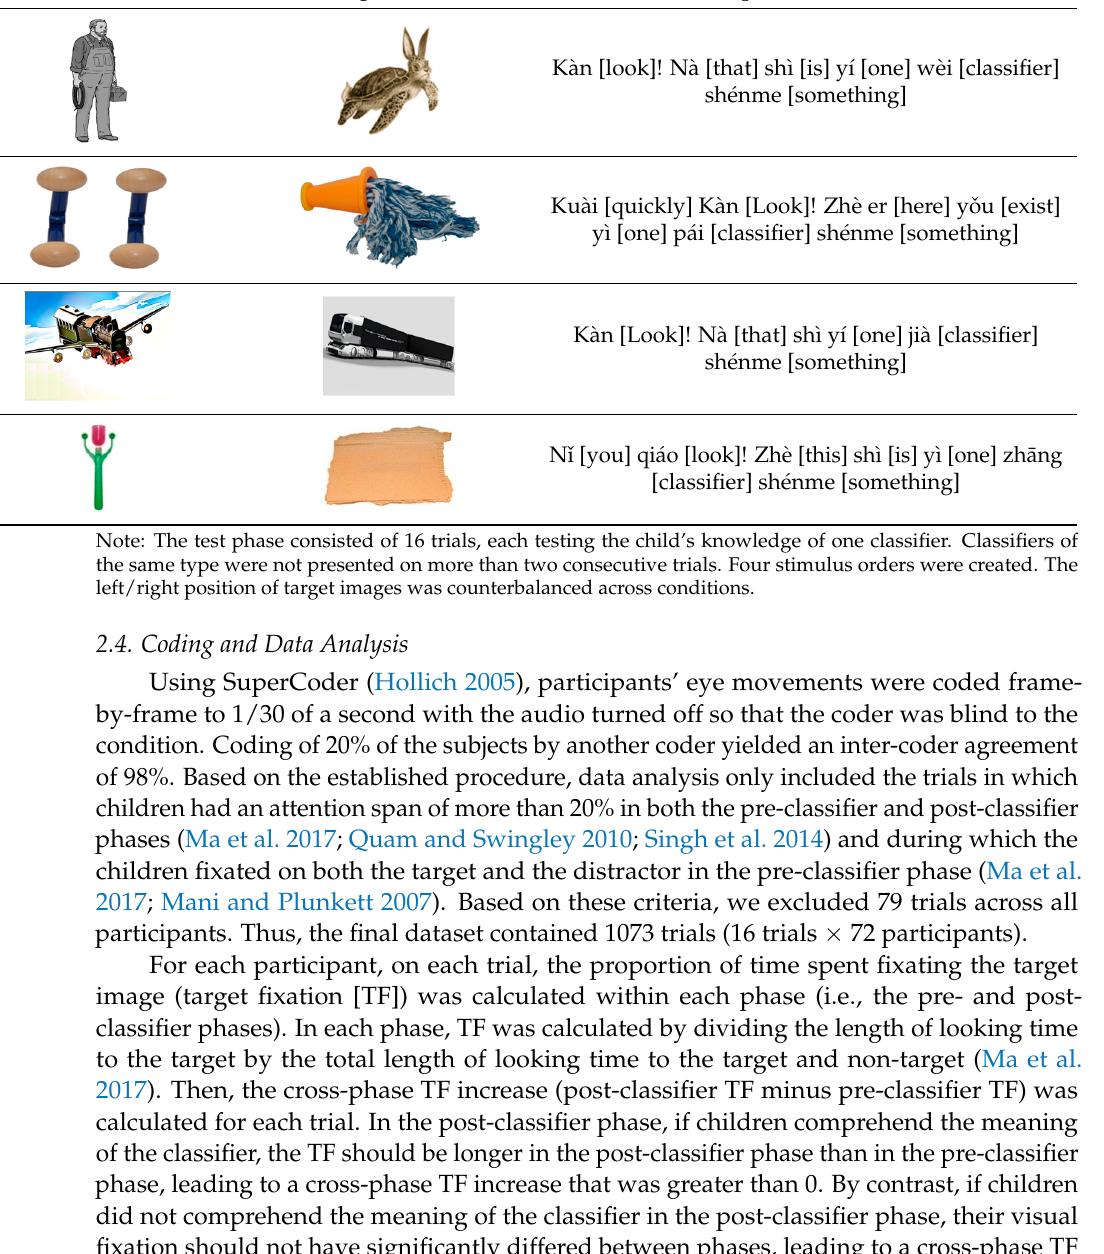
Table 3. An example of trials for the visual and speech stimuli.